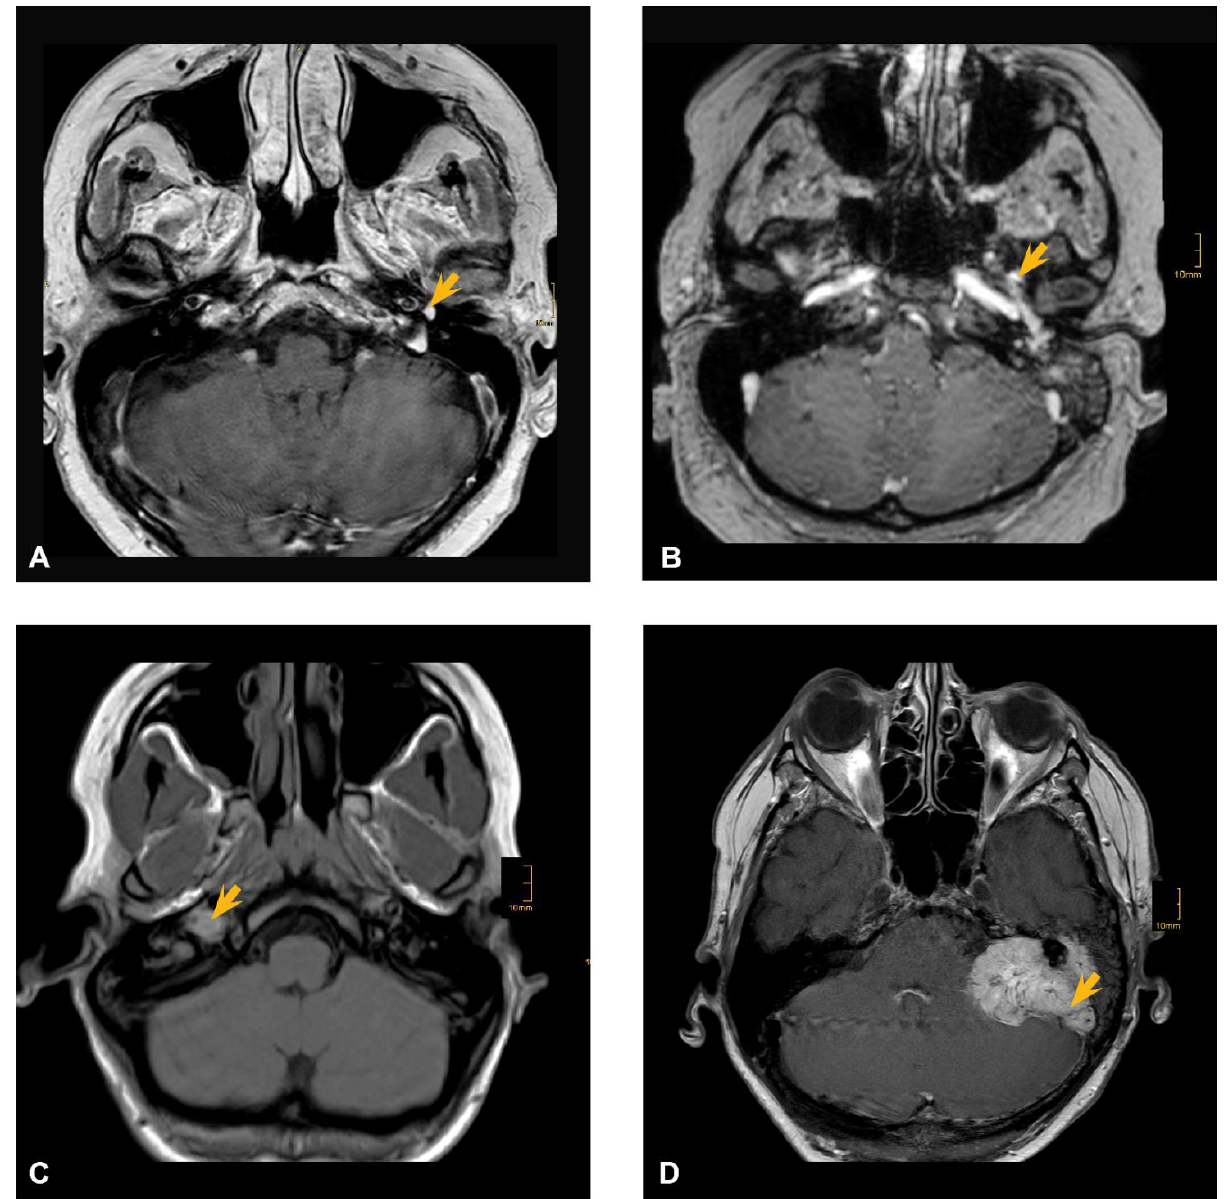
Figure 1. MRI examples of Fisch grades ( A – D ) in the respective population. ( A ) cranial MRI scan of Fisch A1 TBP, ( B ) cranial MRI scan of Fisch B3, ( C ) cranial MRI scan of Fisch C1, ( D ) cranial MRI scan of Fisch De2. The yellow arrow indicates tumor location in each radiological scan.